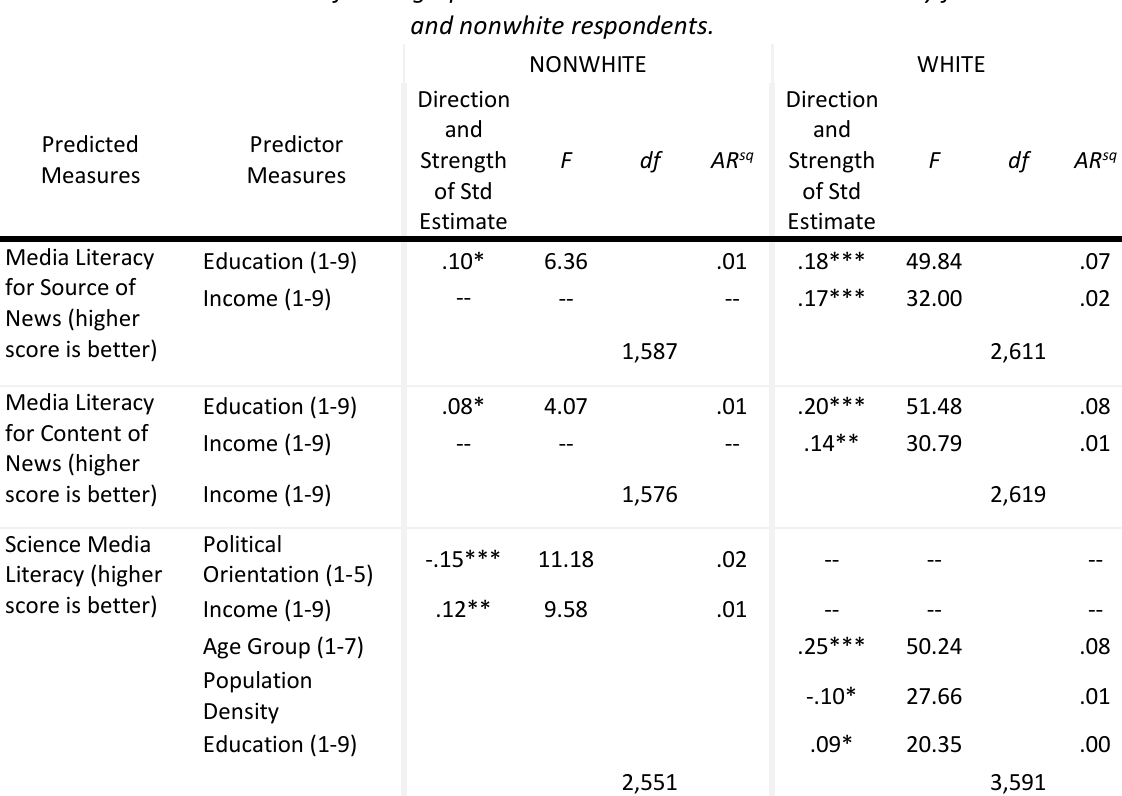
Table 2. Associations of demographics with media and science media literacy for white and nonwhite respondents.